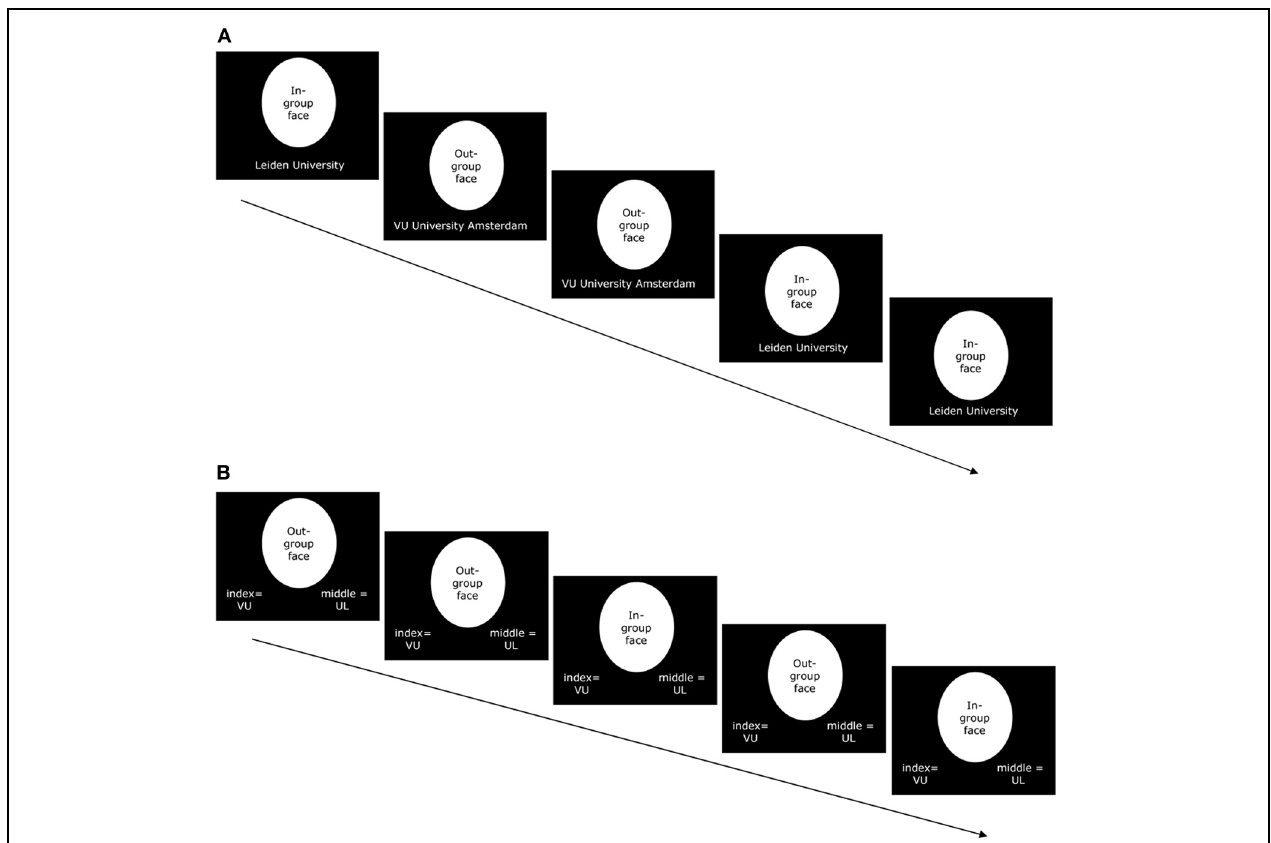
phase of the learning task that was performed outside of the scanner. Participants were presented with targets of their in-group (7 males Leiden University students) or of their out-group (7 males VU University Amsterdam students) and had to indicate the university affiliation of each target (VU = VU University Amsterdam; UL = Leiden University). Trials appeared in complete sequences of all 14 targets (targets were presented in random order within each sequence). The testing phase ended when participants had flawlessly categorized all 14 targets in two subsequent sequences.